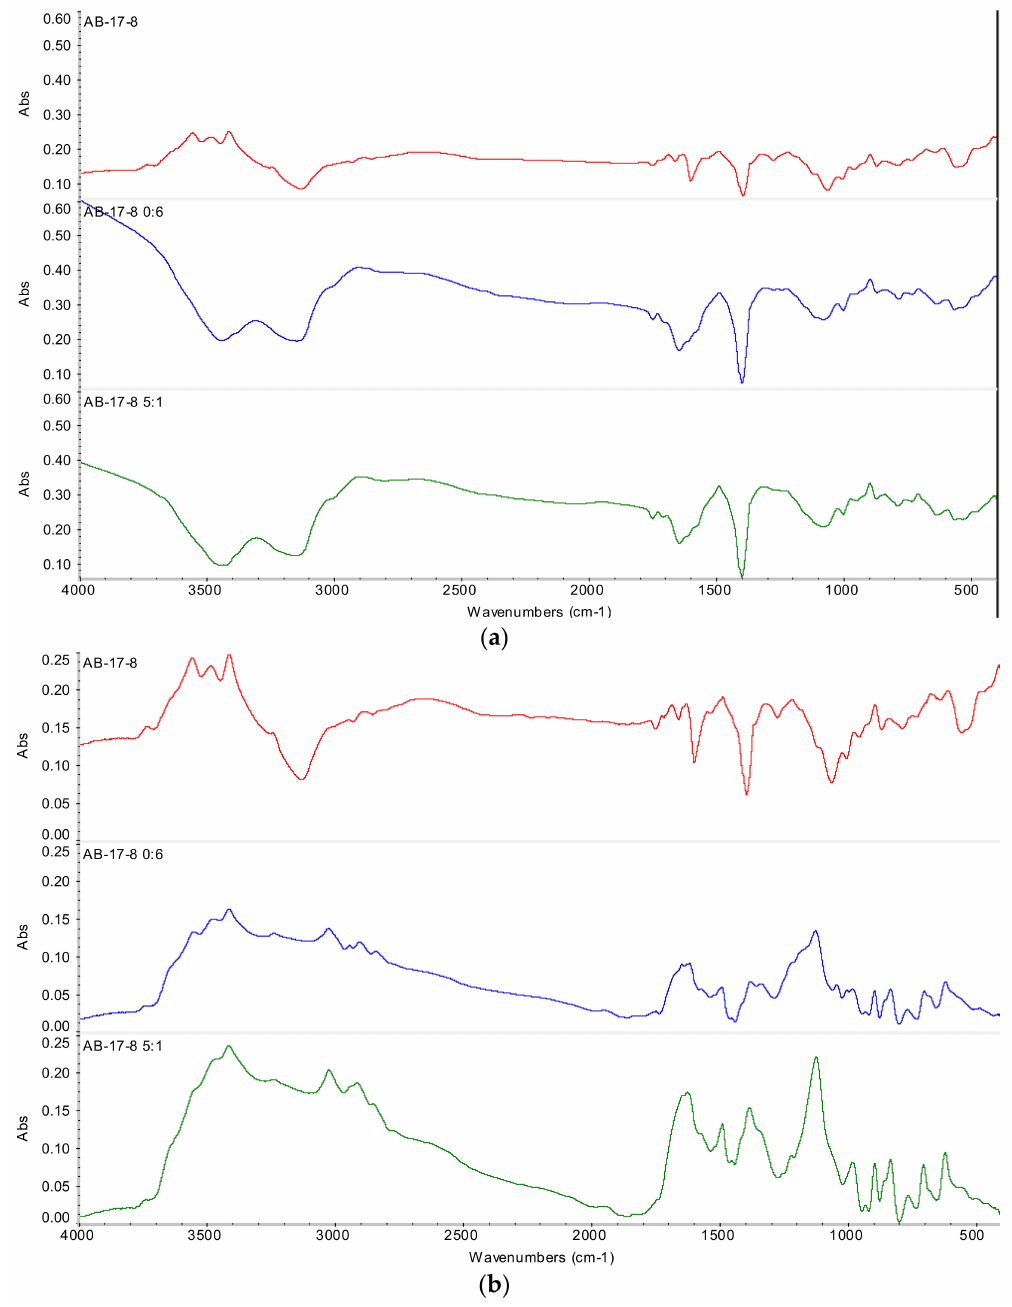
Figure 10. FTIR spectra of ( a ): AB-17-8; AB-17-8 0:6 (with Nd 3+ ions); AB-17-8 5:1 (with Nd 3+ ions) and ( b ) AB-17-8; AB-17-8 0:6 (with Sc 3+ ions); Amberlite IR120 5:1 (with Sc 3+ ions). 3.4.2. TGA Analysis of the Initial Ion-Exchangers and the Interpolymer Pair Amberlite IR120:AB-17-8 =